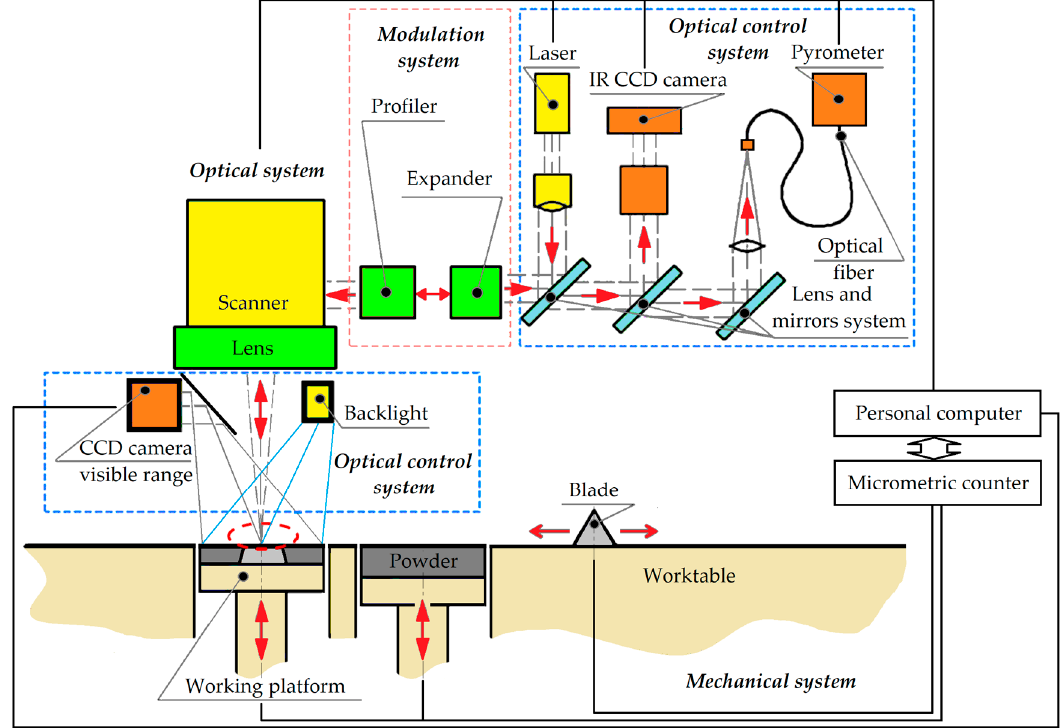
Figure 1. Experimental setup, where CCD is a charge-coupled device, IR is infrared.